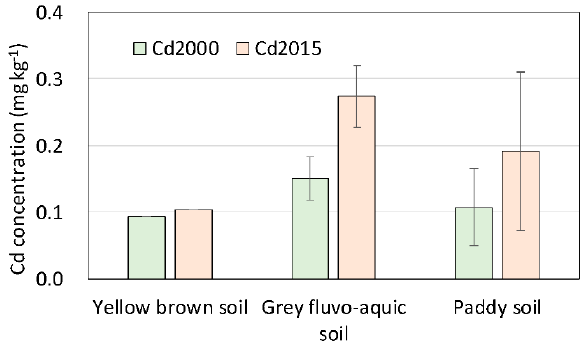
Figure 8. Soil Cd (Cadmium) concentrations in predominant soil types of the study area.